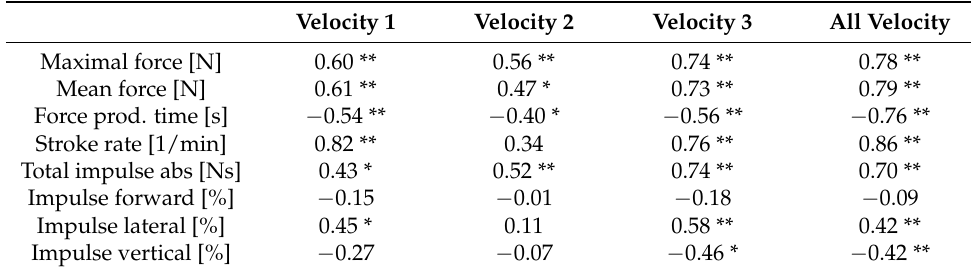
Table 4. The Spearman’s rank correlation coefficient by velocity groups ( n =